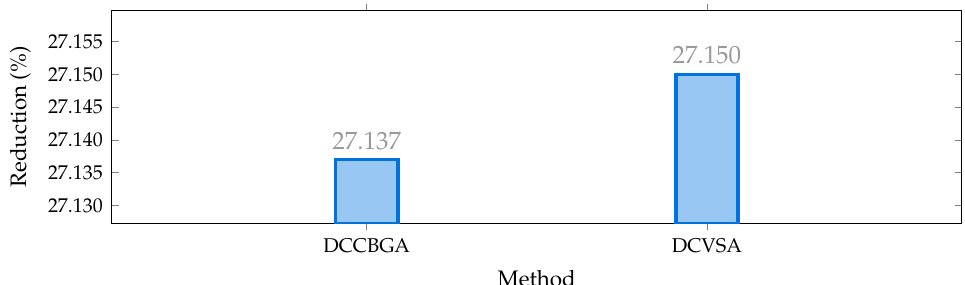
Figure 7. Percentage of reduction of the total grid operative costs in the IEEE 69-bus system in its AC version.